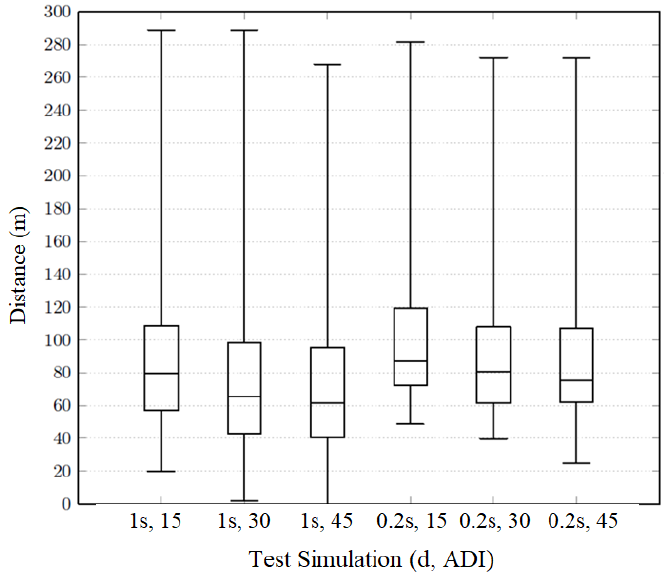
Figure 13. Warning distance of the